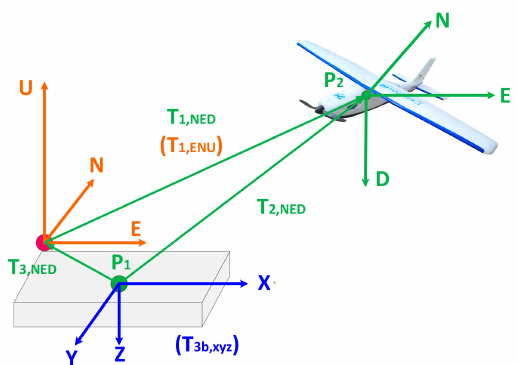
Figure 7. Guidance and coordinate transformation